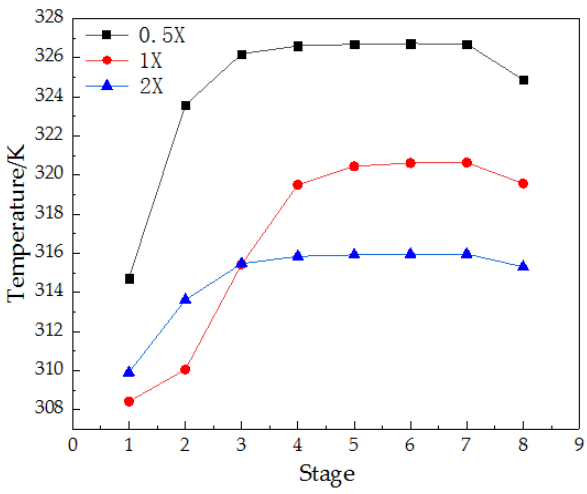
Figure 4. Influence of heat capacity at constant pressure of [emim][Tf 2 N] on the temperature distri- bution curve of absorber. Black represents 0.5X, red represents 1X, and blue represents 2X.